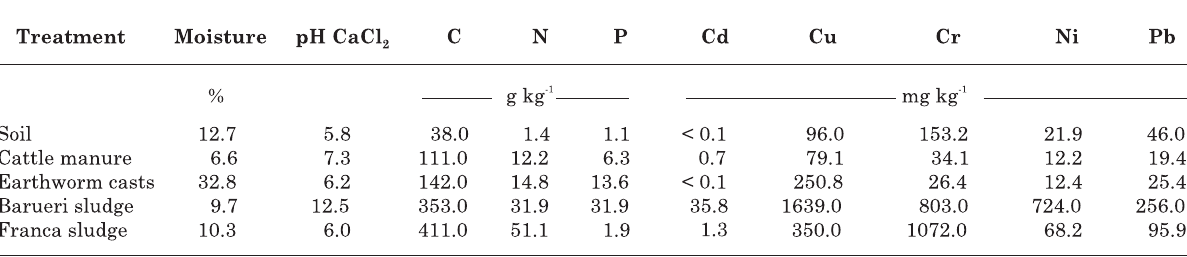
Table 1. Chemical properties of Rhodic Eutrudox soil and the organic residues cattle manure, earthworm casts and municipal sewage sludges from Barueri and